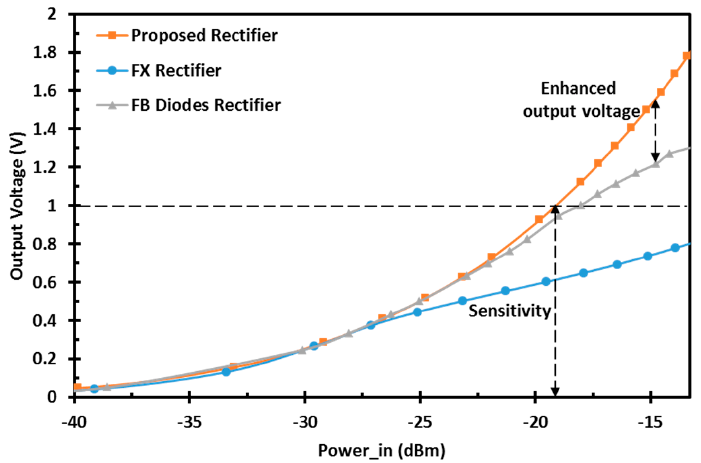
Figure 6. Simulated PCE for conventional FX and FB diodes, and proposed rectifiers vs. the input RF power.